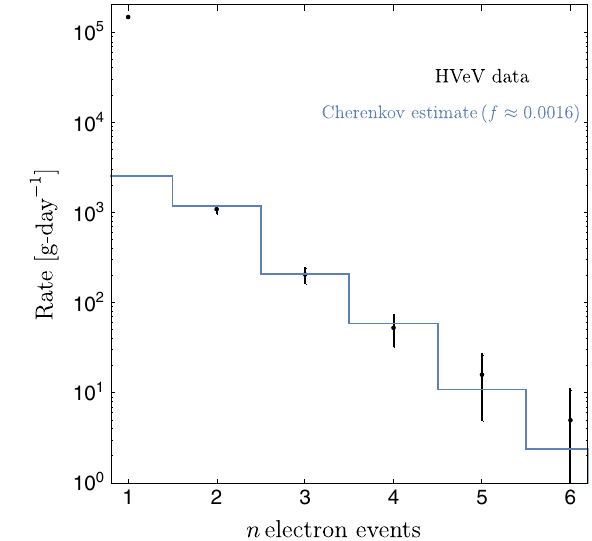
FIG. 18. The spectrum of Cherenkov photons that are able to escape the PCB, produced by an average single charged particle interacting in the PCB. The sharp drop in the spectrum at approximately 8 eV is due to the SiO 2 component of the PCB, which becomes highly absorptive at photon frequencies close to and above the material ’ s band gap. See Appendix C 1 for details.